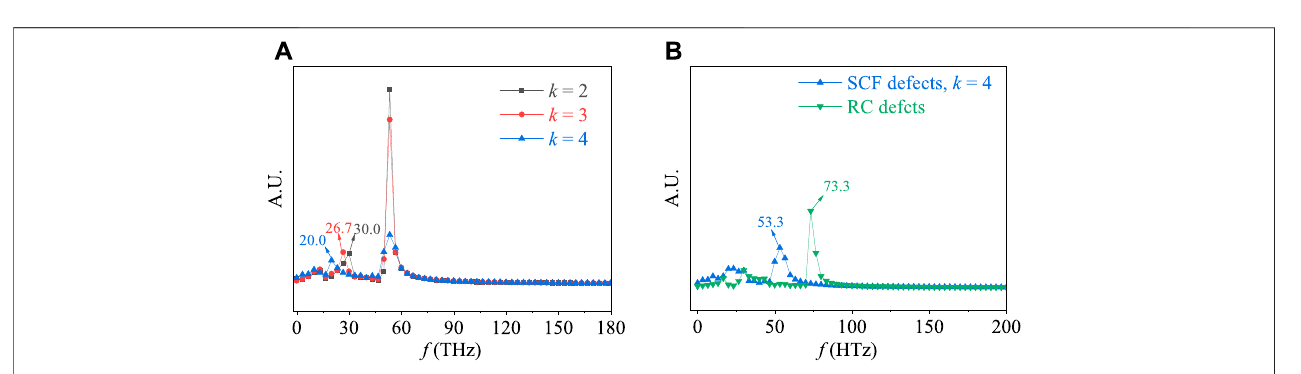
FIGURE 3 | PDOS of graphene with two defective defects: (A) effect of the fractal level and (B) Comparison between SCF and RC defects.